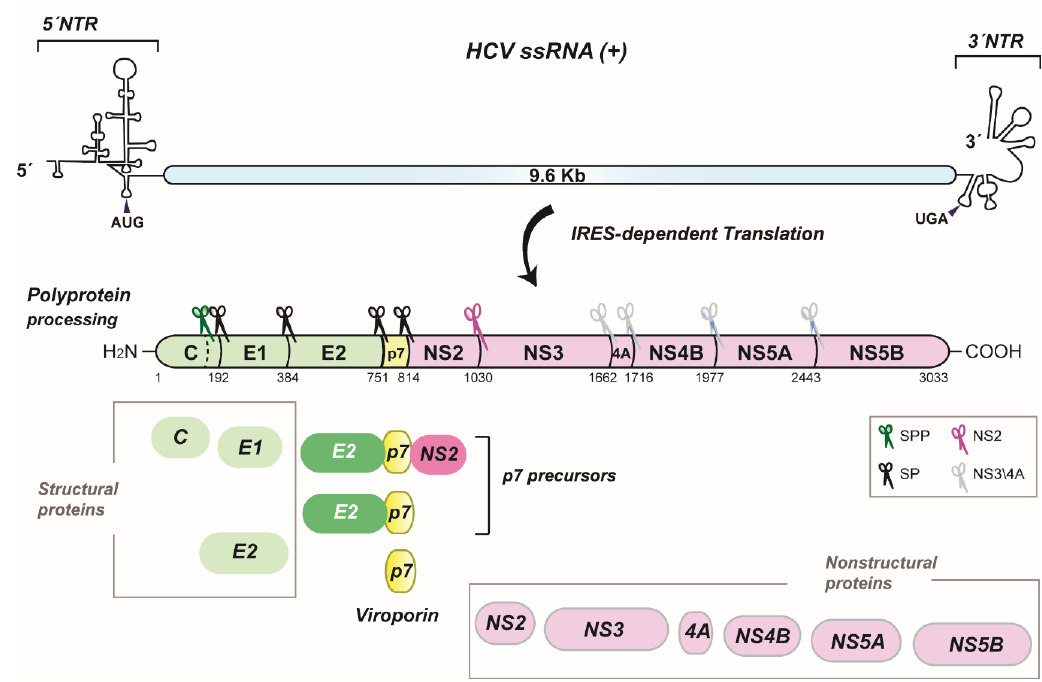
Figure 1. HCV genome organization, polyprotein processing and p7 precursors. A schematic representation of the HCV RNA genome including the non-translated regions (NTR) at the 5′ and 3′ ends and the coding region is shown on the top. AUG and UGA indicate the start and stop codons of the long open reading frame, respectively. The polyprotein precursor generated by IRES-dependent RNA translation and cleavage products are shown below. Numbers refer to amino acid positions of the JFH-1 isolate (GenBank accession number AB047639). Nonstructural proteins are depicted in pink color, p7 in yellow and structural proteins in green. Cellular and viral proteases responsible for polyprotein cleavage are represented by scissors and specified in the box. SPP, signal peptide peptidase; SP, signal peptidase. p7 precursors and p7 are highlighted.